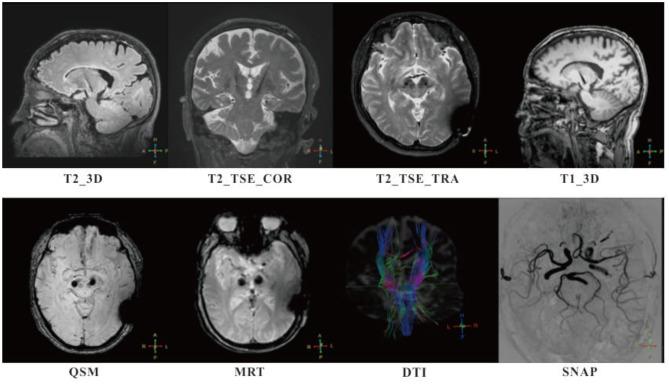
Follow-ups of patients with MR-compatible deep brain stimulation (DBS) implanted were successfully completed at 1, 3, 6, and 12 months, with intensive 3T MR scan. High in-plan resolution T2-weighted fast spin echo sequences (T2_TSE_COR and T2_TSE_TRA) and high specific absorption rate (SAR) isotropic sequences (T1_3D, T2_3D, and QSM) were adopted for anatomy analysis. Simultaneous non-contrast angiographies (SNAP) and diffusion tensor imaging (DTI) were taken for monitoring potential lesion on blood vessels and edema occurrence. A special sequence, magnetic resonance thermometry (MRT) used for tissue temperature online assessment. No adverse events were found that related to MRI.